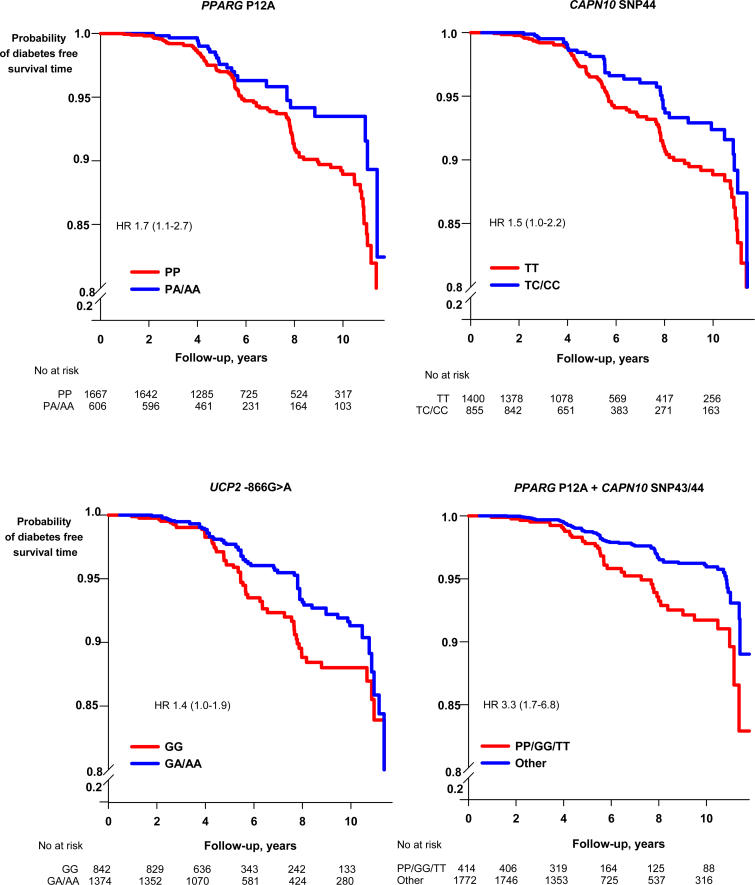
Unadjusted Kaplan–Meier Diabetes-Free Survival Probability CurvesCurves for different carriers of PPARG P12A (PP versus PA/AA), CAPN10 SNP44 (TT versus TC/CC), UCP2 −866 G/A (GG versus GA/AA), and the combination of PPARG and CAPN10 SNP43/44 (PP/GG/TT versus other). y-Axis shows probability of diabetes-free survival time. x-Axis shows follow-up time in years. The HR of developing T2D in different genotype carriers obtained from Cox proportional hazards regression stratified on sex and adjusted for age, BMI, and family history of diabetes with robust variance estimate is shown (see also Table 3).